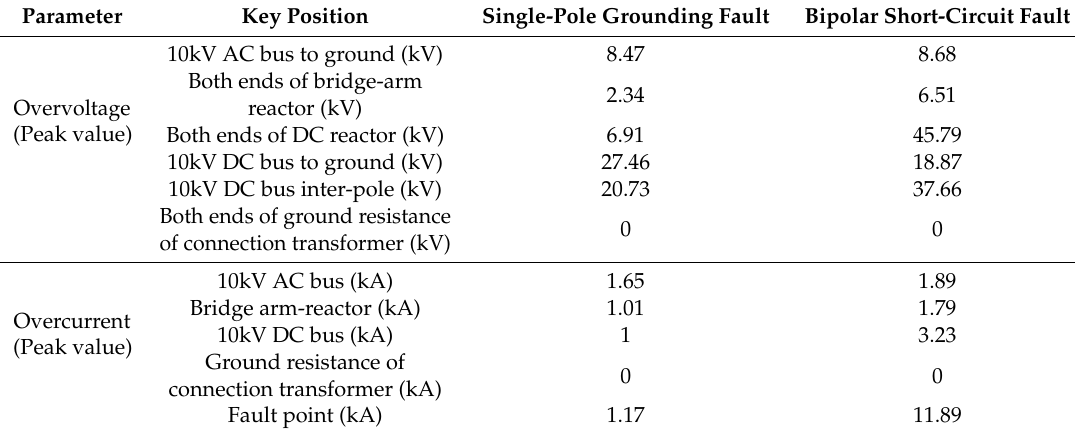
Table 6. Overvoltage and overcurrent levels of di ff erent positions during the DC system side fault. Parameter